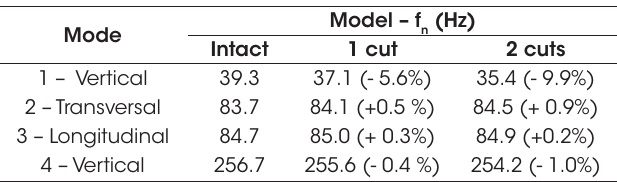
Comparison between the natural